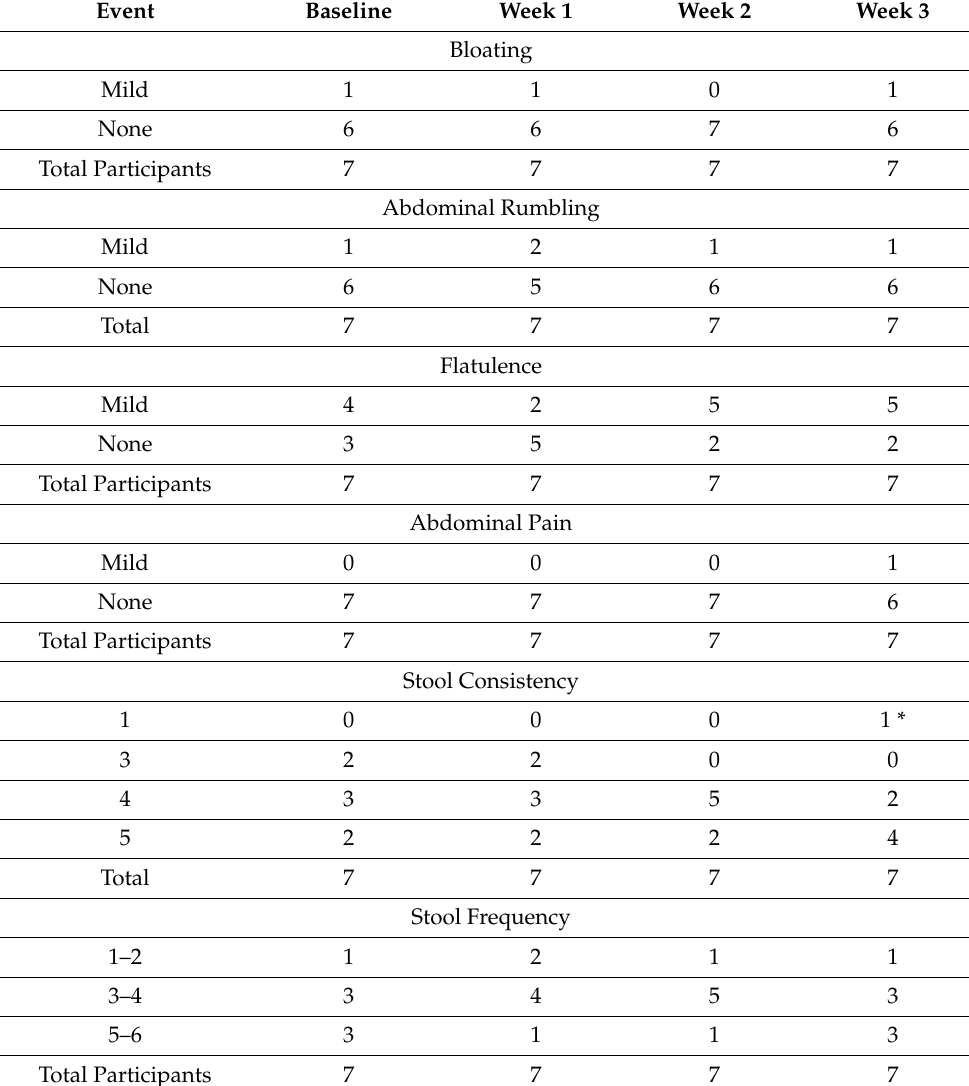
Table 3. Participant responses to gastrointestinal symptoms, stool consistency, and stool frequency. Event